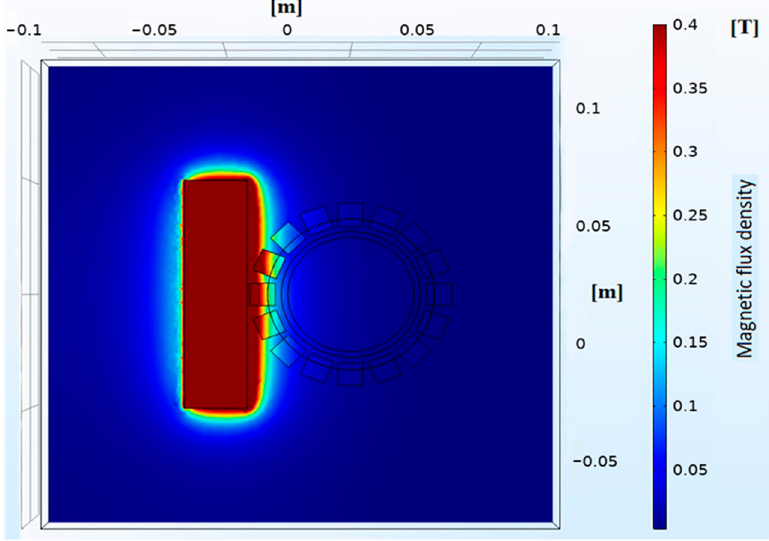
Figure 2. Magnetic flux density around the heat engine.